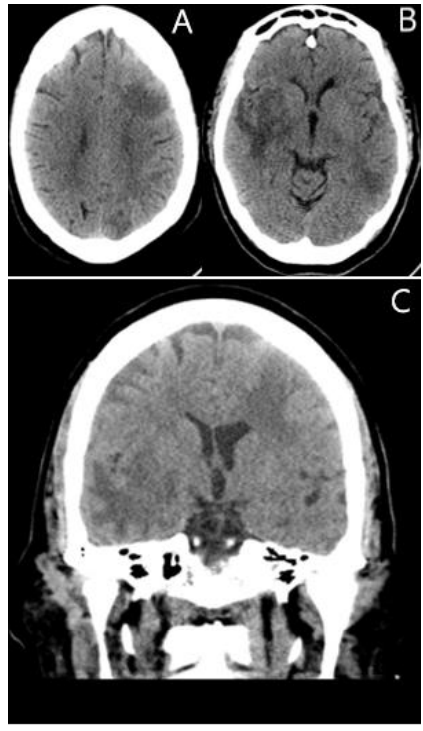
Figure 1. ( A – C ) Unenhanced Axial and Coronal CT images demonstrating vasogenic edema with a mass effect within the left frontal and bilateral temporal lobes. There is mild compression of the left lateral ventricle secondary to a left frontal lesion ( C ).